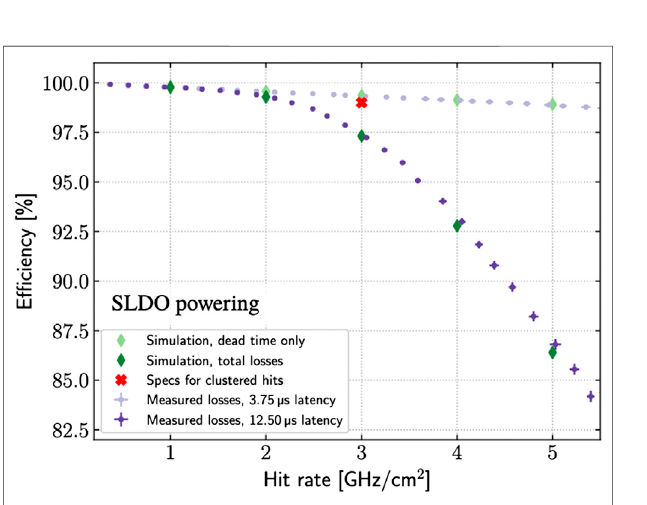
FIGURE 7 | Hit losses determined by the dimension of the local pixel region data storage are shown for simulation studies in the case of 2 × 2 (A) and 4 × 4 (B) architectures studied From [18, 19].